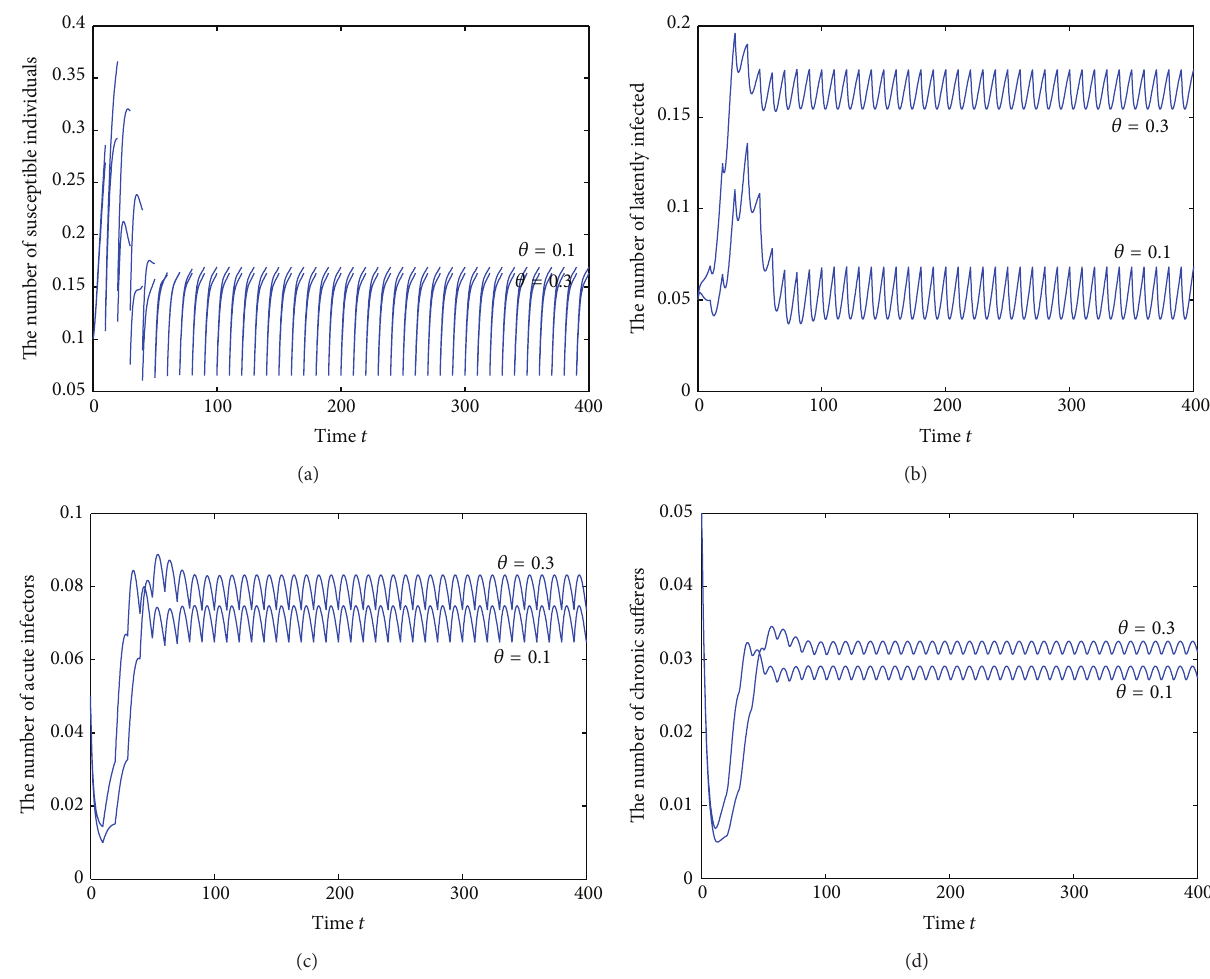
Figure 2: The effect of vaccine efficacy on the number of (a) susceptible individuals, (b) latently infected, (c) acute infectors, and (d) chronic sufferers. The parameters are 𝜇 = 0.1 ; 𝜐 = 0.1 ; 𝜑 = 0.1 ; 𝛽 = 3 ; 𝜀 = 0.016 ; 𝛾 2 = 0.025 ; 𝜇 1 = 0.28 ; 𝜏 = 10 ; 𝜔 = 0.2 ; 𝑞 = 0.4 ; 𝛾 1 = 0.4 ; 𝜃 = 0.3 ; (0) = 0.05 ; 𝐼 (0) = 0.05 ; 𝑉(0) = 0.1 ; 𝑅(0) = 0.1 𝑝 = 0.6 ; the initial values are 𝑆(0) = 0.1 ; 𝐿(0) = 0.05 ; 𝐼 1 2